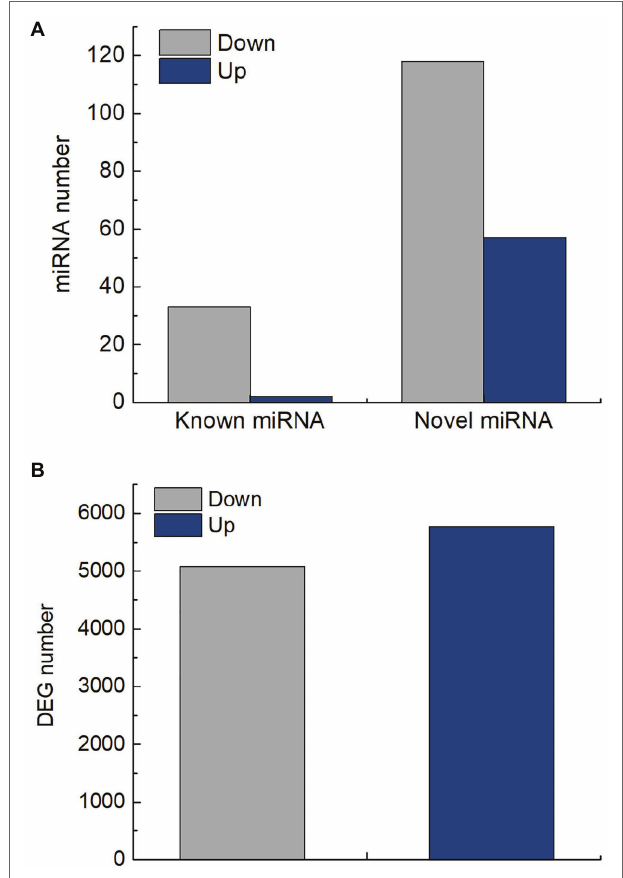
FIGURE 3 | The number of differentially expressed miRNAs and genes in QM6 roots in response to salt stress. (A) The number of up-regulated and down-regulated known and novel miRNAs after 24 h of salt stress. (B) The number of up-regulated and down-regulated genes after 24 h of salt